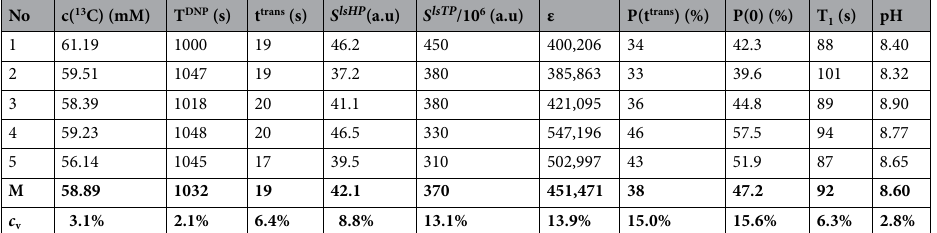
Table 7. Reproducibility of hyperpolarized 13 C pyruvate in aqueous solution as contrast agent for MRI. Mean and coefficient of variance ( c v ) for concentration of 1- 13 C-PA after the dissolution, fitted time constant of the trans hyperpolarization build-up (T DNP ), transfer time t to 1 T NMR, liquid-state NMR signal of hyperpolarized sample S lsHP normalized to the largest signal (sample 4), liquid-state NMR signal in thermal equilibrium lsTP ( S ) normalized to the largest signal (sample 1), polarization at the time of measurement P(t trans ) , estimated polarization directly after the dissolution P(0) and lifetime (T 1 ) of hyperpolarization at 1 T (the enhancement was calculated using flip angle α = 5º, RG = 31, ns = 1 for hyperpolarized sample, and α = 20º, with a RG = 31, and ns = 3600 for the thermally polarized sample). Significant values are in [bold].